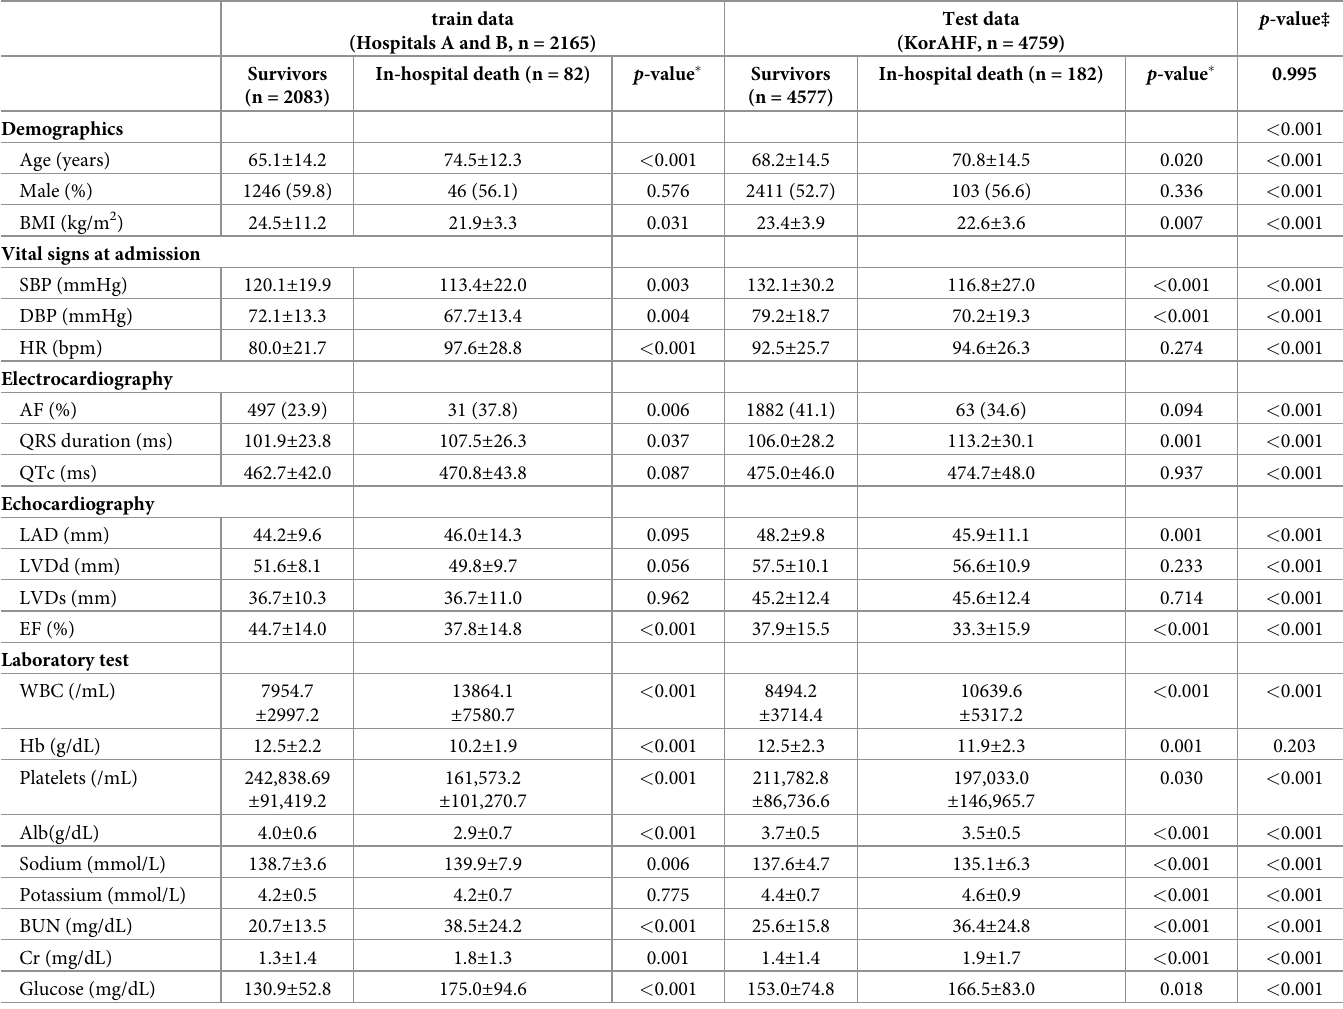
Table 1. Baseline